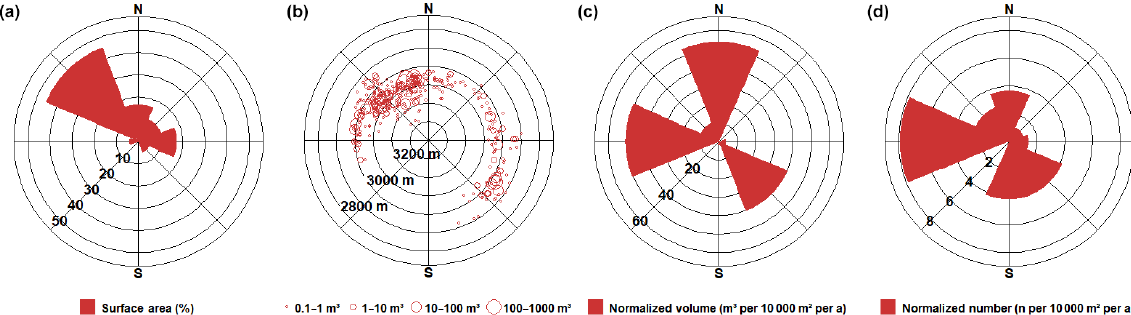
Figure 9. (a) Sectoral distribution of surface area. (b) Slope azimuth angle and elevation in ma . s . l . for all rockfalls. (c) Normalized rockfall